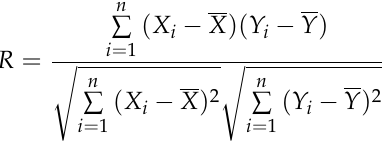
Figure 11. Diagram of the lift cylinder.